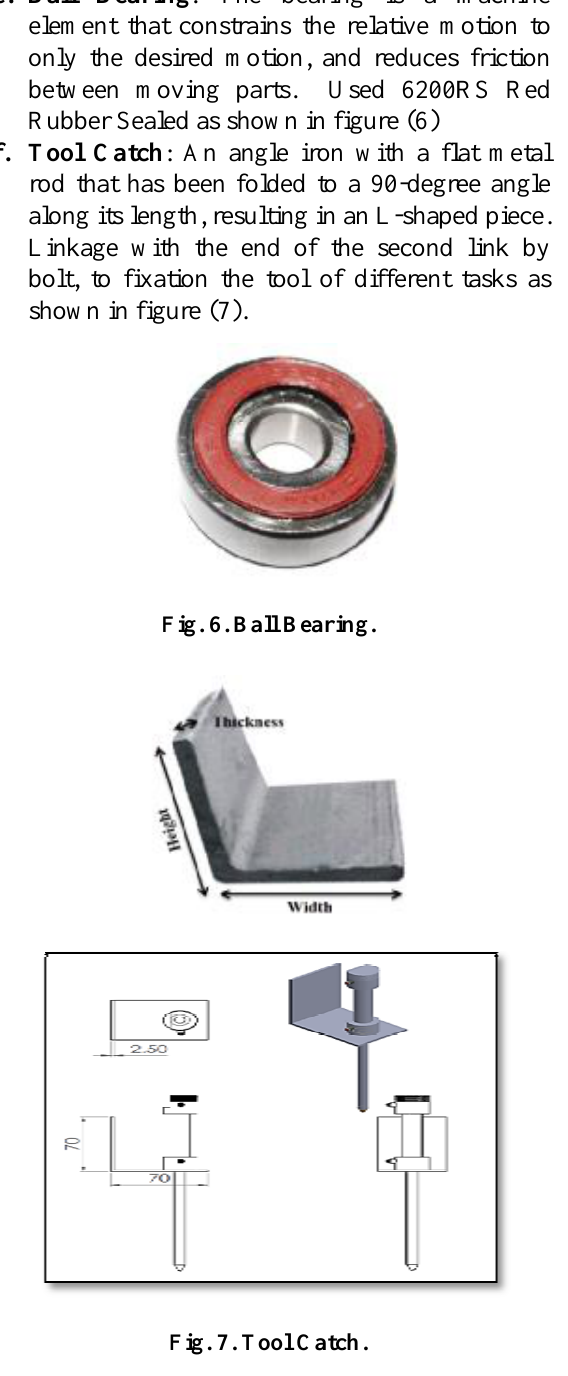
Fig. 7. Tool Catch.